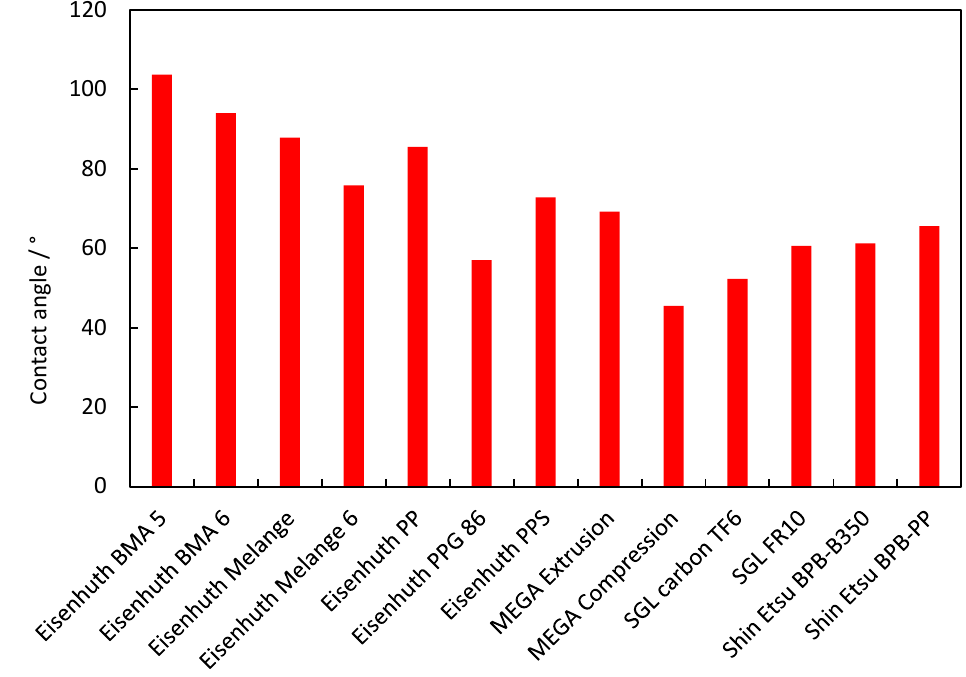
Figure 15. Contact angle of the individual BP materials under study.